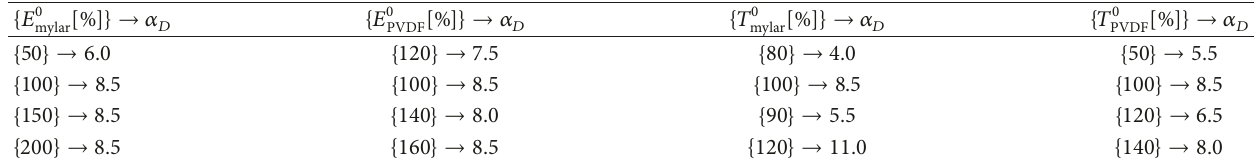
Table 2: Computation of 𝛼 𝐷 coefficients [ 10 −6 N/mm 3